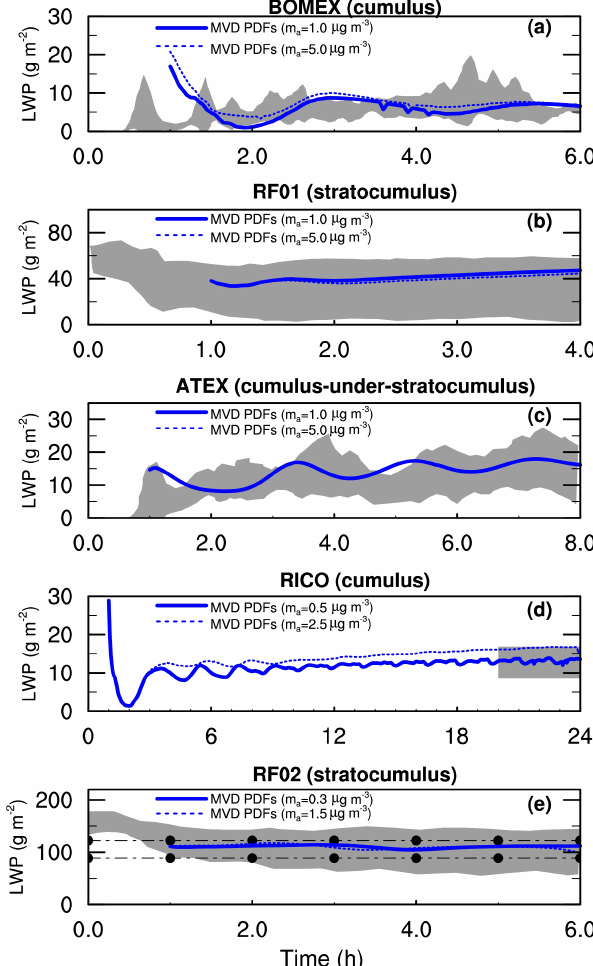
Fig. 1. Time series of liquid water path (LWP) for BOMEX in (a) , RF01 in (b) , ATEX in (c) , RICO in (d) , and RF02 in (e) at dif- ferent sulfate aerosol mass concentrations ( m a ). The time series from the MVD PDFs begin from the first hour when microphysics is activated. The solid and dotted curves are overlapped in (c) be- cause the changes in LWP are small when m a increases from 1.0 to 5.0µgm − 3 in ATEX. Shaded areas in (a), (b), (c), and (e) indicate the ranges of the LES ensemble. The shaded area in (d) indicates the LWP ranges of S-S LES averaged over the last 4h. Dots in (e) indicate approximate measurement ranges for RF02 (Stevens et al.,